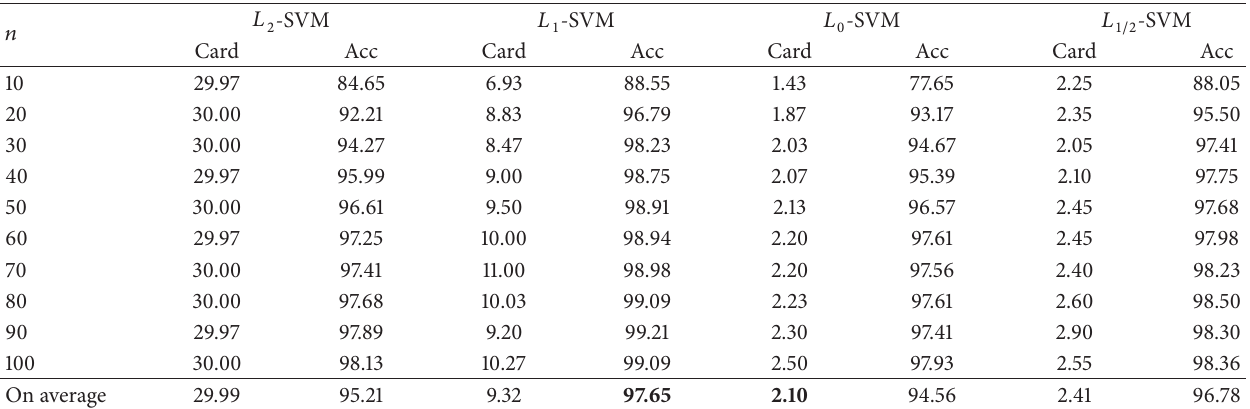
Table 1: Results comparison on 10 artificial data sets with various training sample sizes.